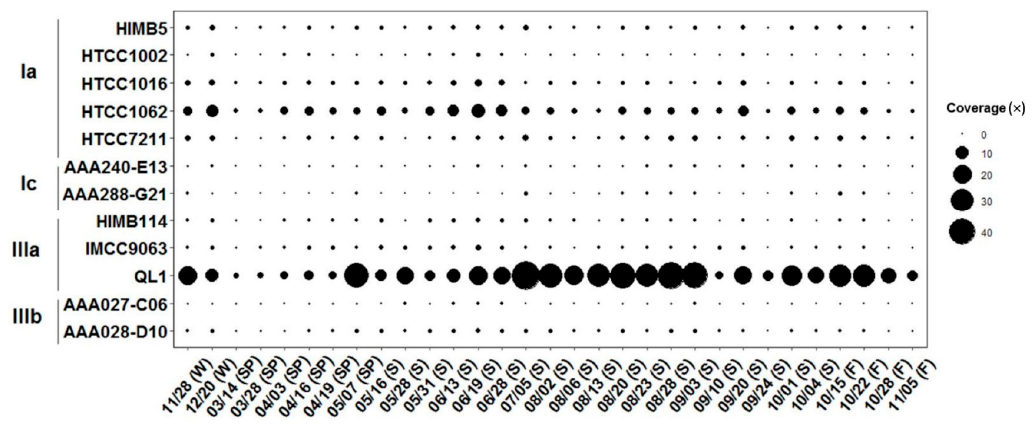
Figure 2. Temporal variation of representative SAR11 bacteria. The circle size represents the relative coverage over the seasons: spring (SP), summer (S), fall (F), and winter (W).